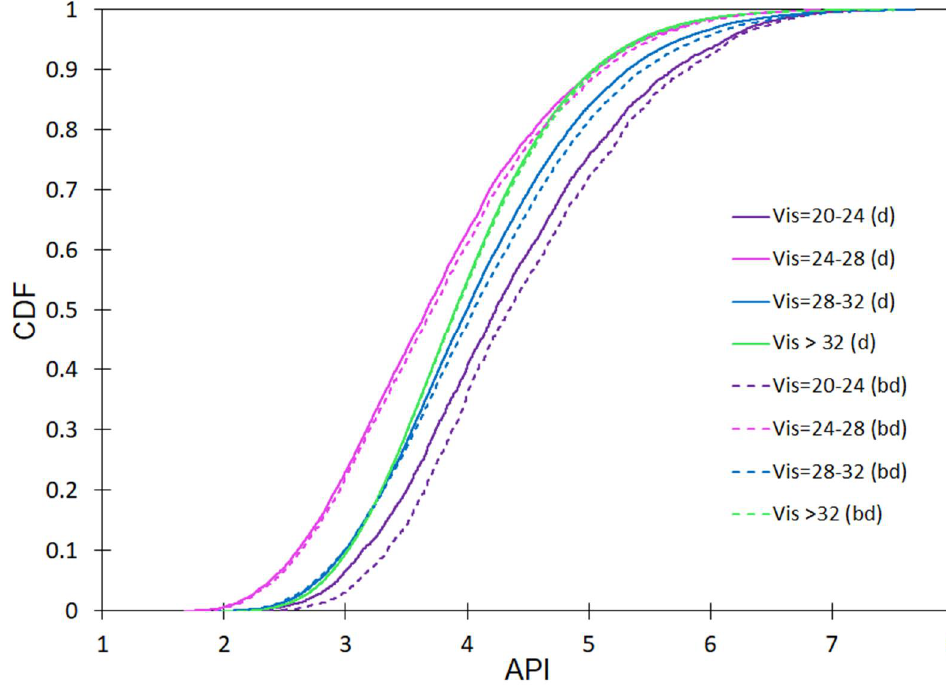
Figure A4. Effect of summer visibility on air pollution index (API).